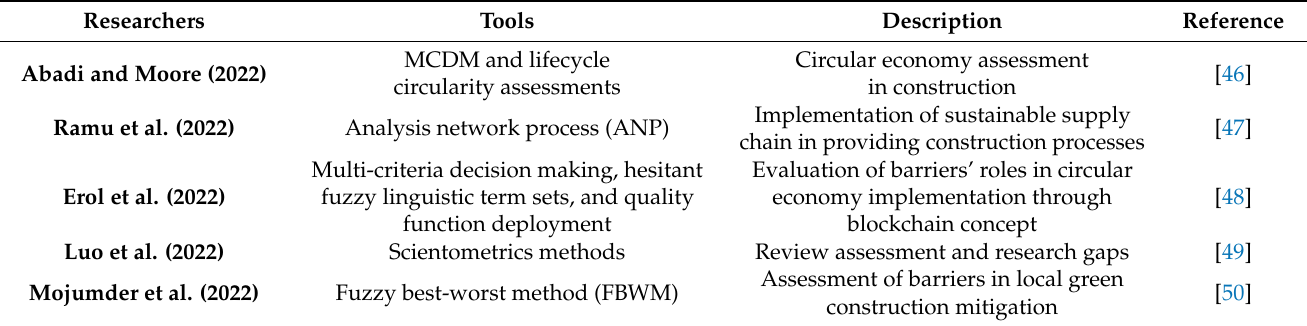
Table 1. Recent research in the aforementioned